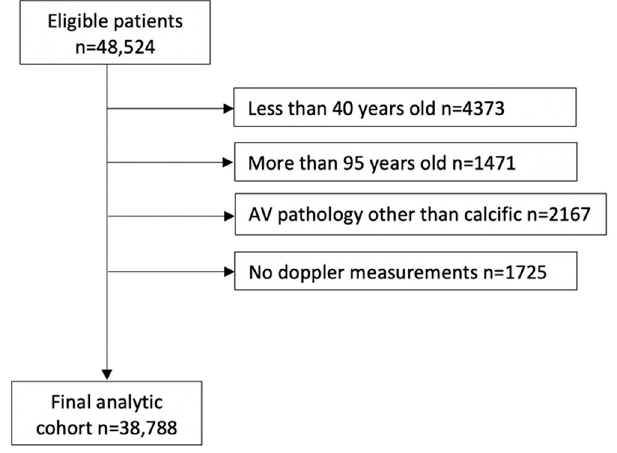
Figure 1. Analytic cohort building. Consort diagram describing the inclusion and exclusion steps that led to the final analytic cohort.